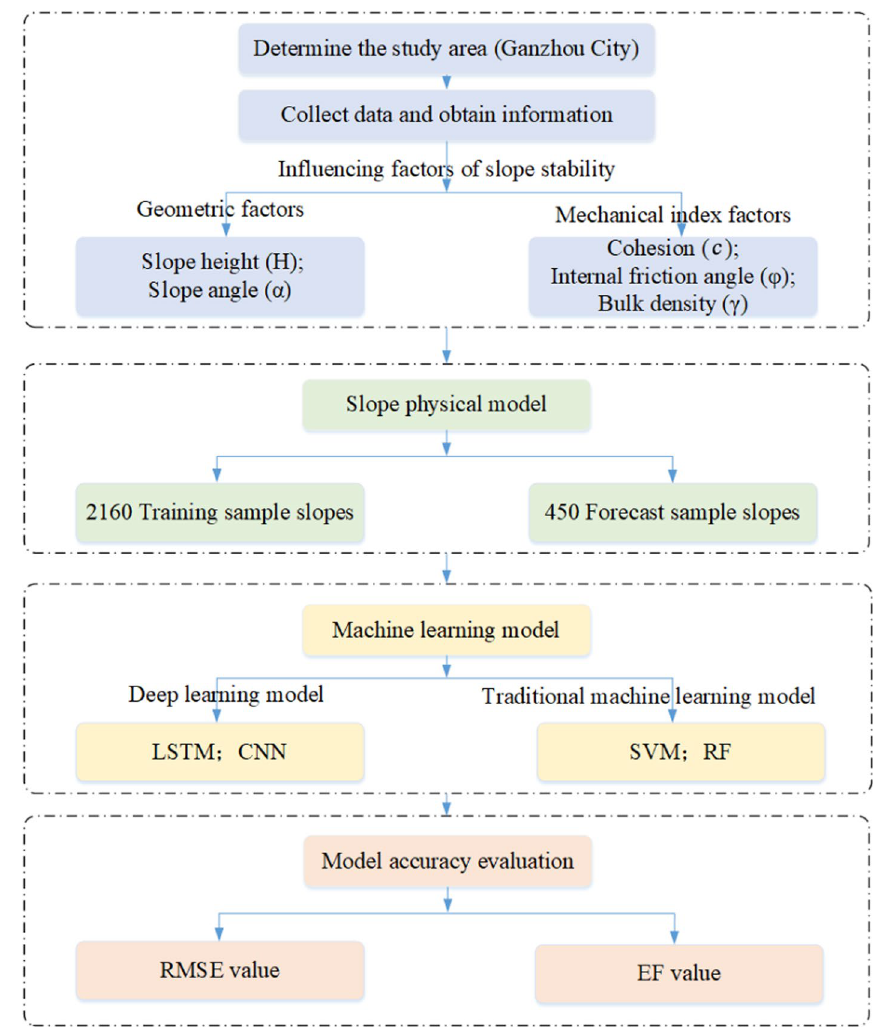
Fig. 2 Modeling flow chart